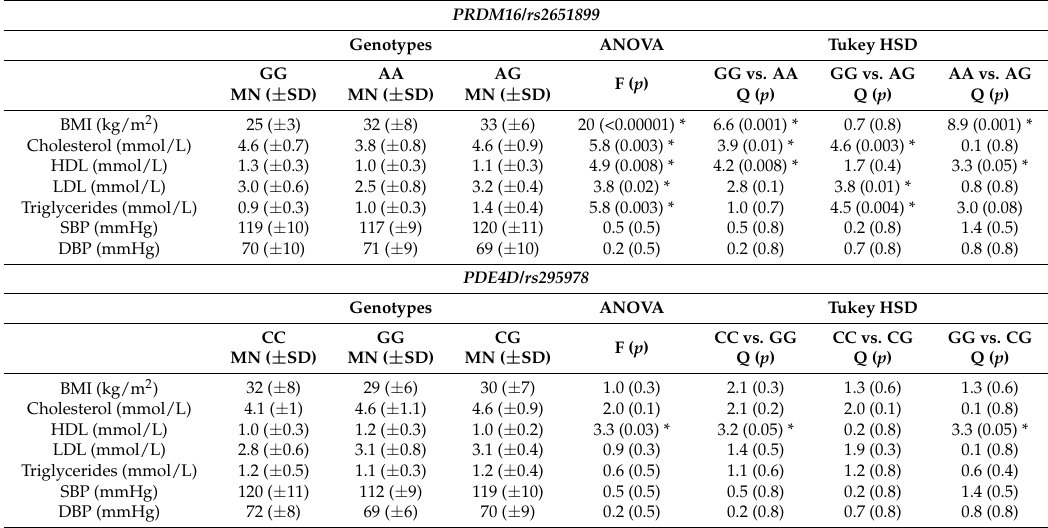
Table 3. Difference in BMI, blood lipids profile and blood pressures among the PRDM16/rs2651899 and PDE4D/rs295978 genotypes